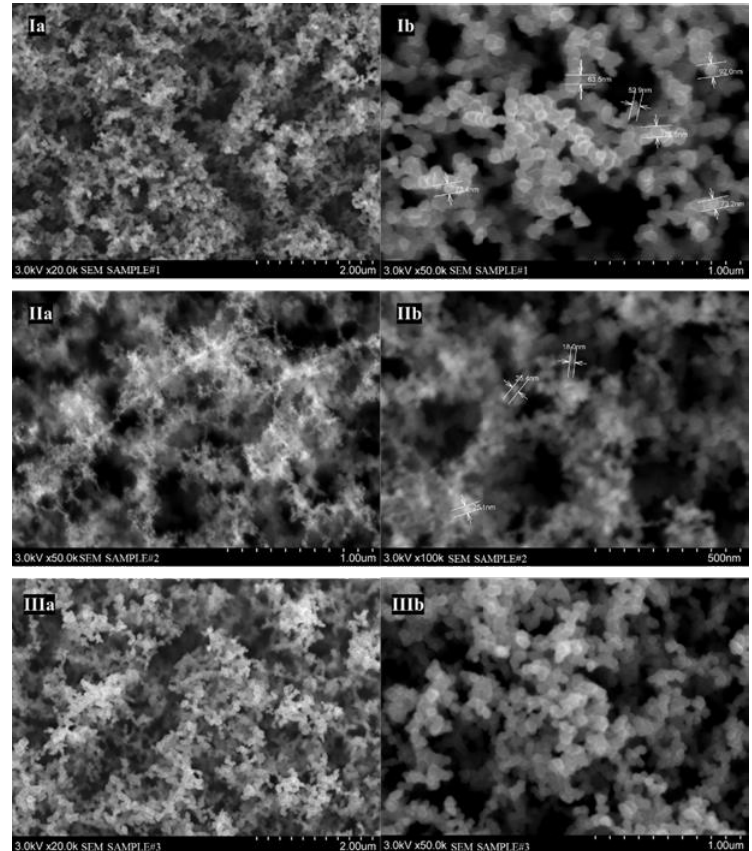
Figure 16. Soot samples at various magnifications; (I) Bakken crude oil, (II) Pennsylvania crude oil, and (III) Colorado crude oil.